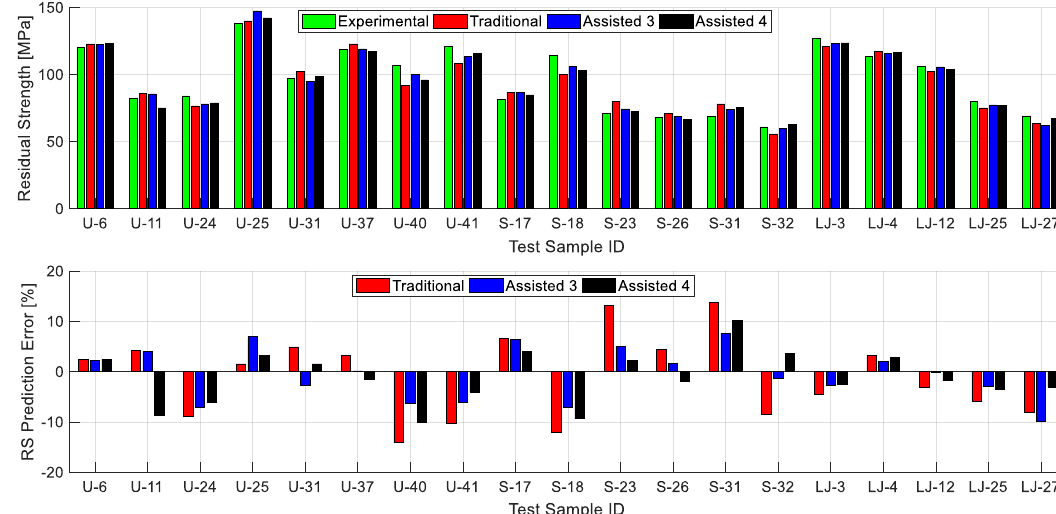
Figure 6. The experimental residual strength values along with the predictions obtained by the ANN model built using the reduced size training dataset (reduced 3) for the traditional and assisted approaches (assisted 3 and 4 only) for one of the testing datasets ( top ), together with the residual strength prediction errors ( bottom ). The shown ANN predictions are for the same testing dataset used in Figure 4.